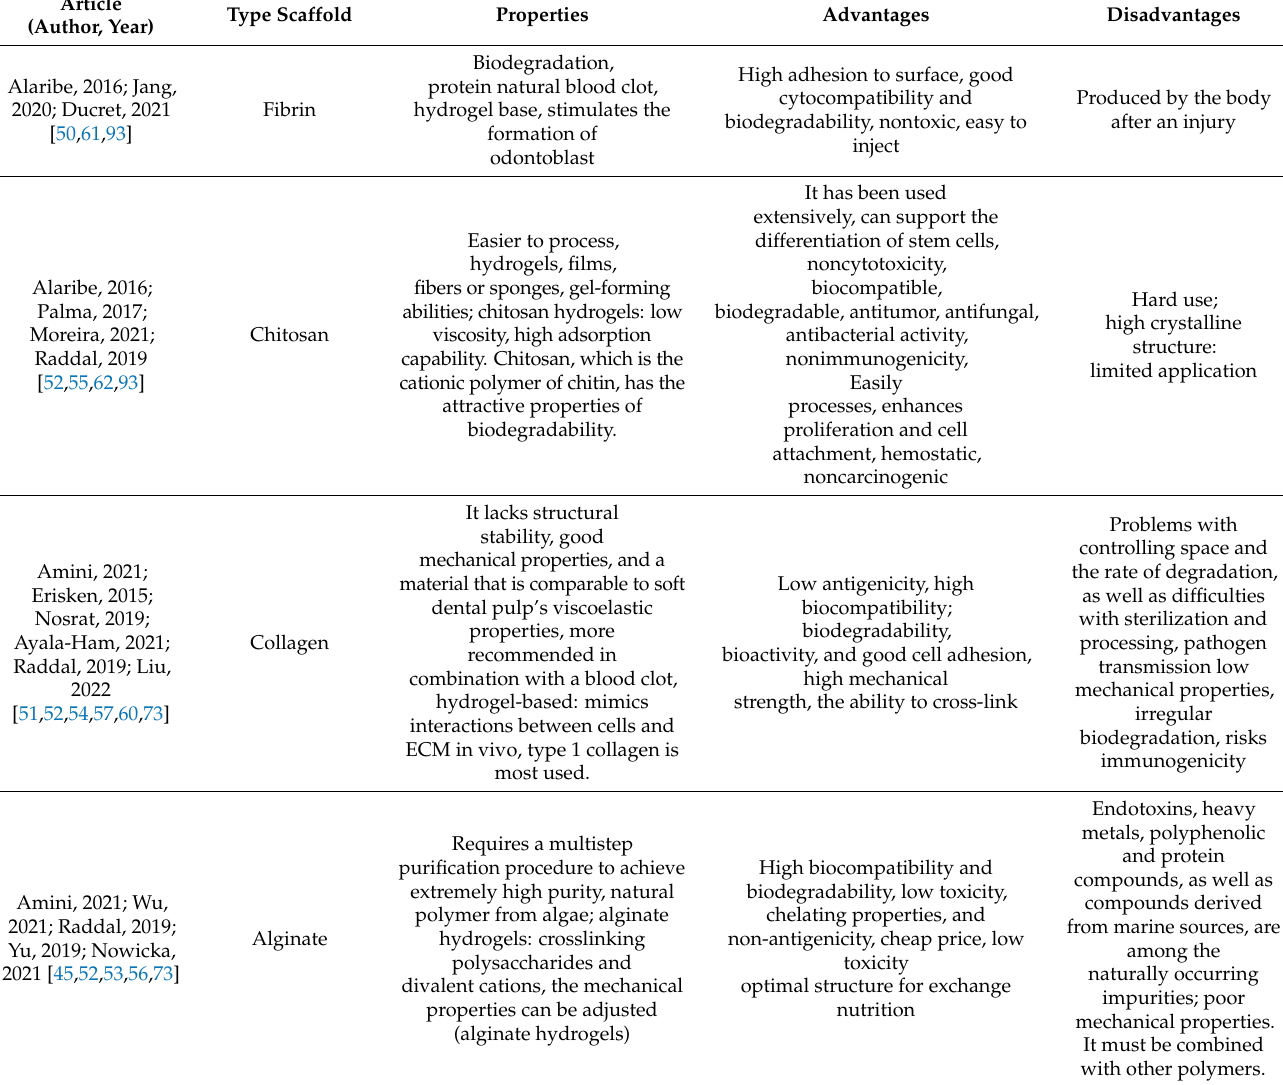
Table 1. Comparison of various types of scaffolds for tissue